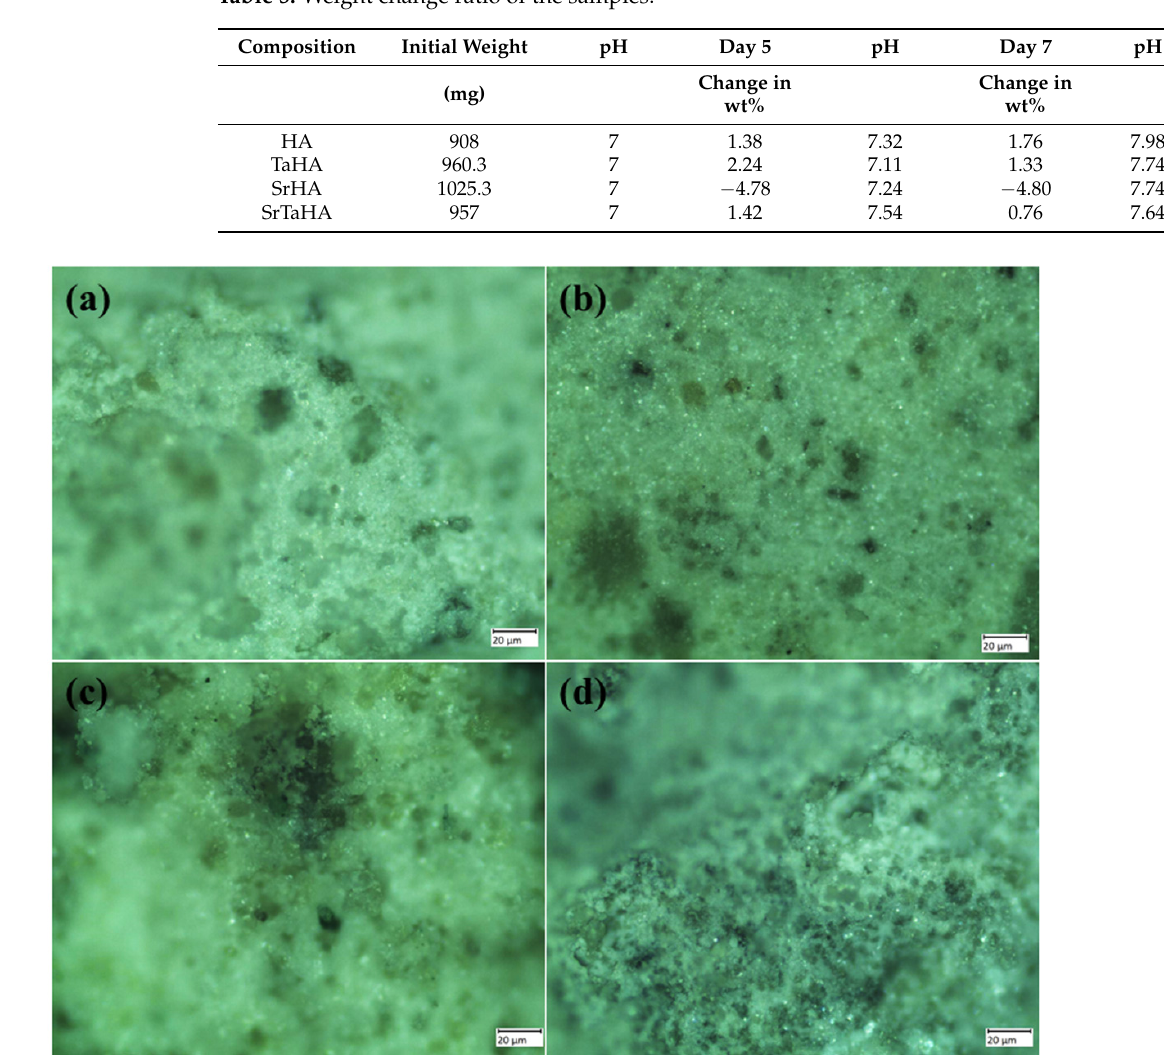
Table 5. Weight change ratio of the samples.